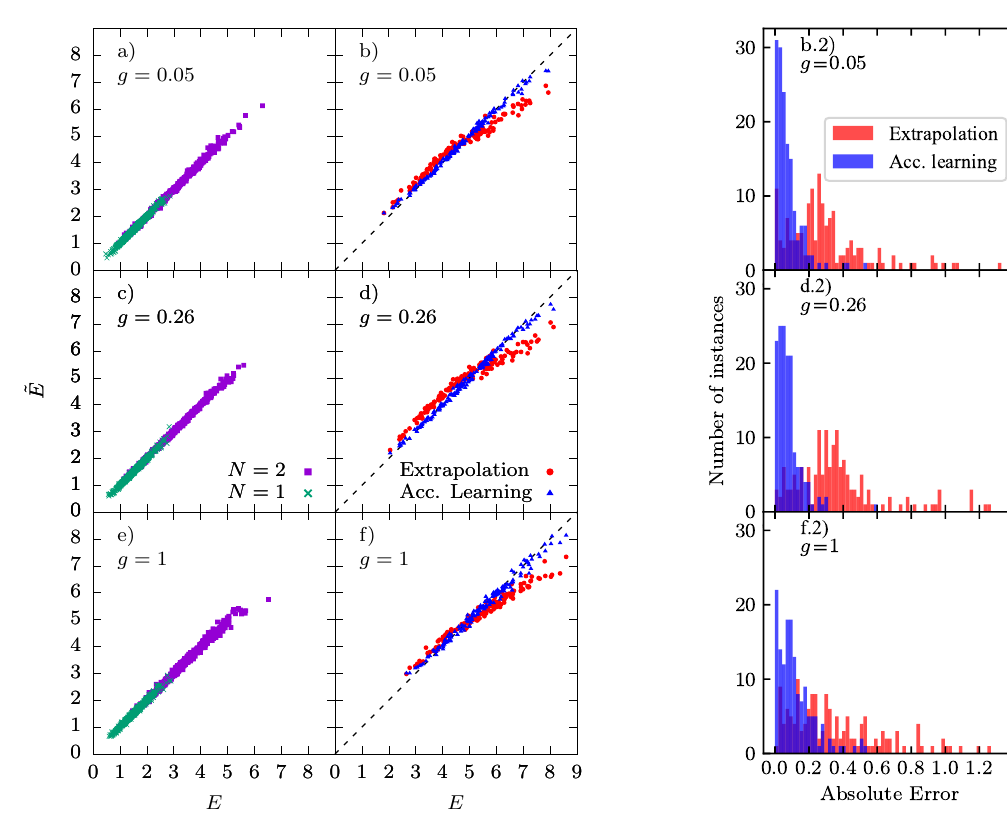
Figure 3: (Left) Ground-state energies ˜ E , predicted by a neural network trained on a heterogeneous dataset, as a function of the exact-diagonalization E . The training sets include 1800 instances for N = 1 and as many for N = 2. Panels (a), (c), and (e) report results for the systems sizes included in the training set. Panels (b), (d), and (f) report the extrapolations to the N = 3 case, and the accelerated learning with 200 additional instances for N = 3. (Right) Panels (b.2), (d.2), and (f.2) show the distributions of the absolute error, | ˜ E − E | , for the extrapolations and the accelerated- learning procedure corresponding to panels (b), (d), and (f), respectively. The three rows correspond to different interaction strengths g